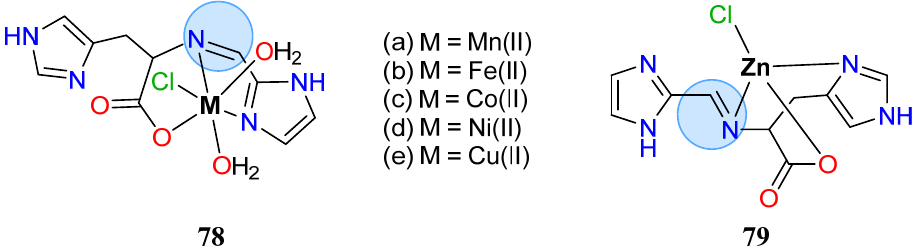
Figure 38. Metal complexes of an imidazole-derived tridentate Schiff base ligand reported for their antimicrobial activity.